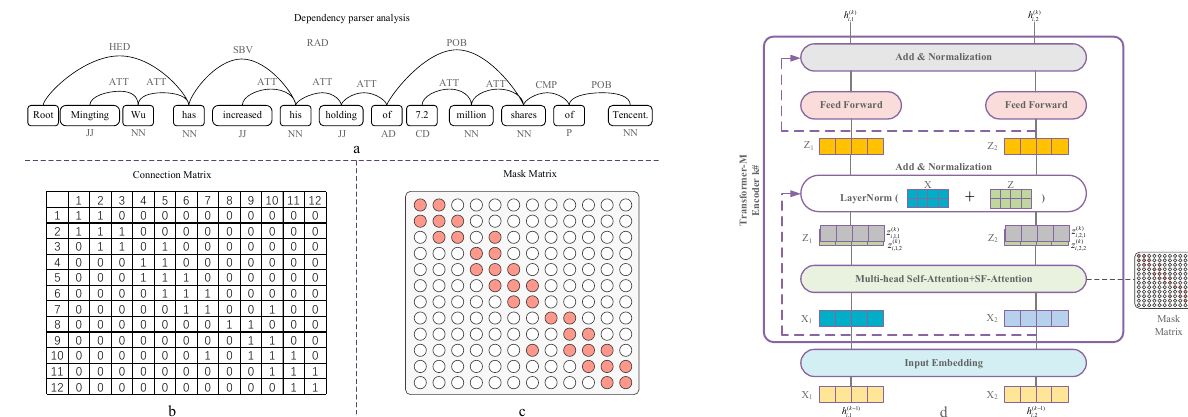
token for S i , which is fed into TF-M to obtain feature enhanced representation. [ · ; · ] denotes the concatenation operation.